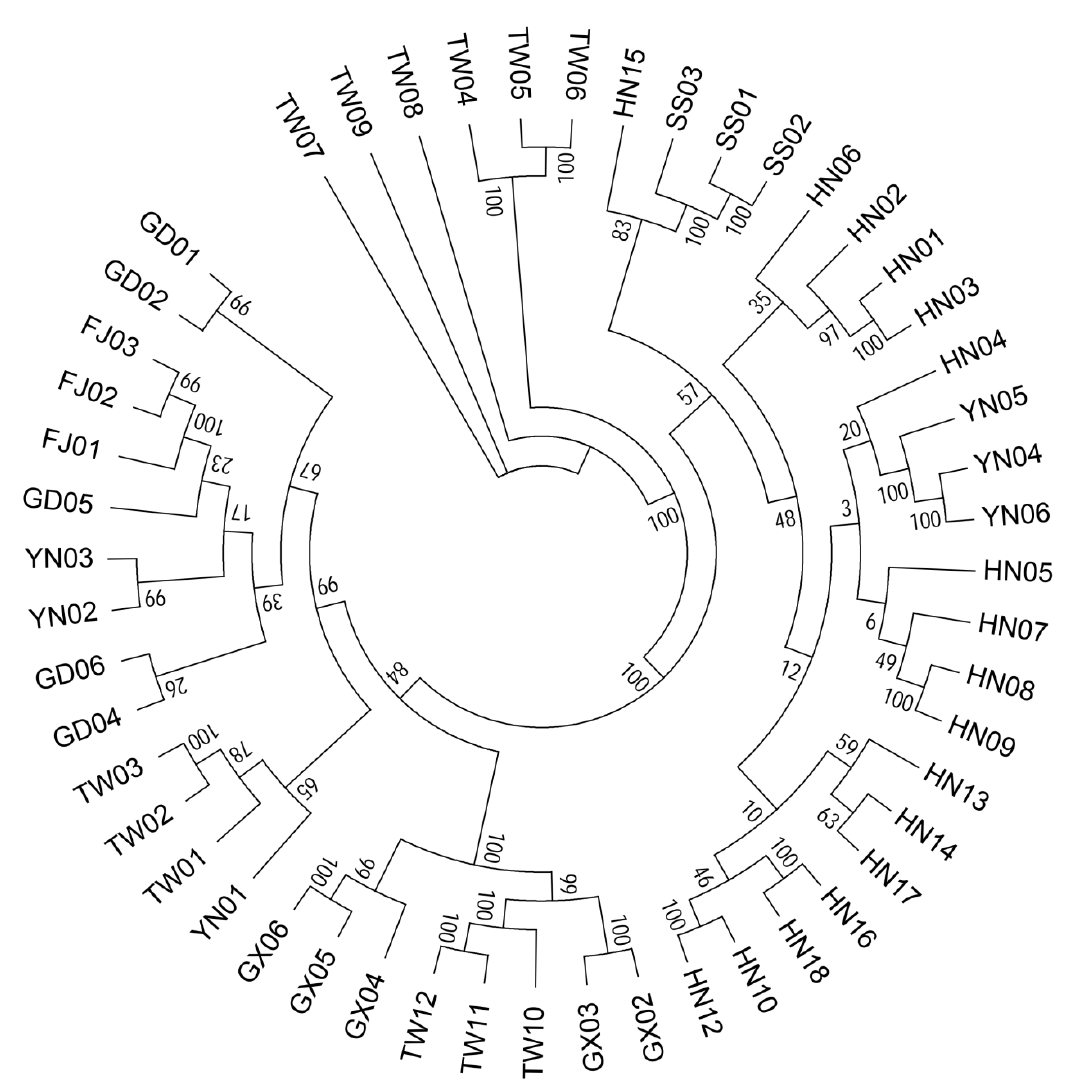
Figure 5. Maximum likelihood (ML) tree of B. longissima accessions collected from Southern China.